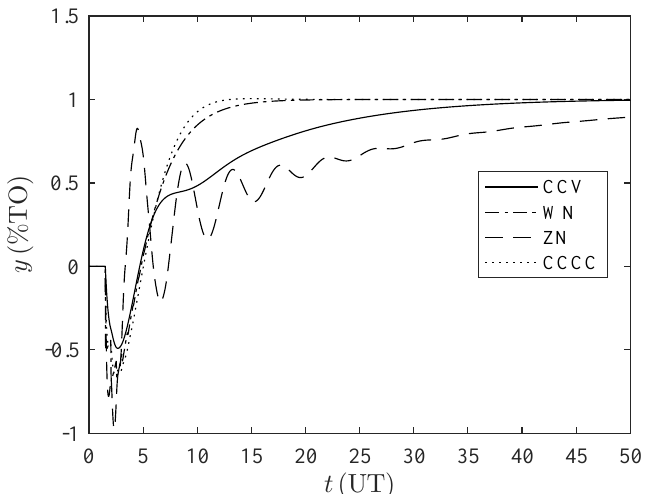
Figure 6. Time response set-point tracking for the set P 4 . %TO: percentage of transmitter output, UT: units of